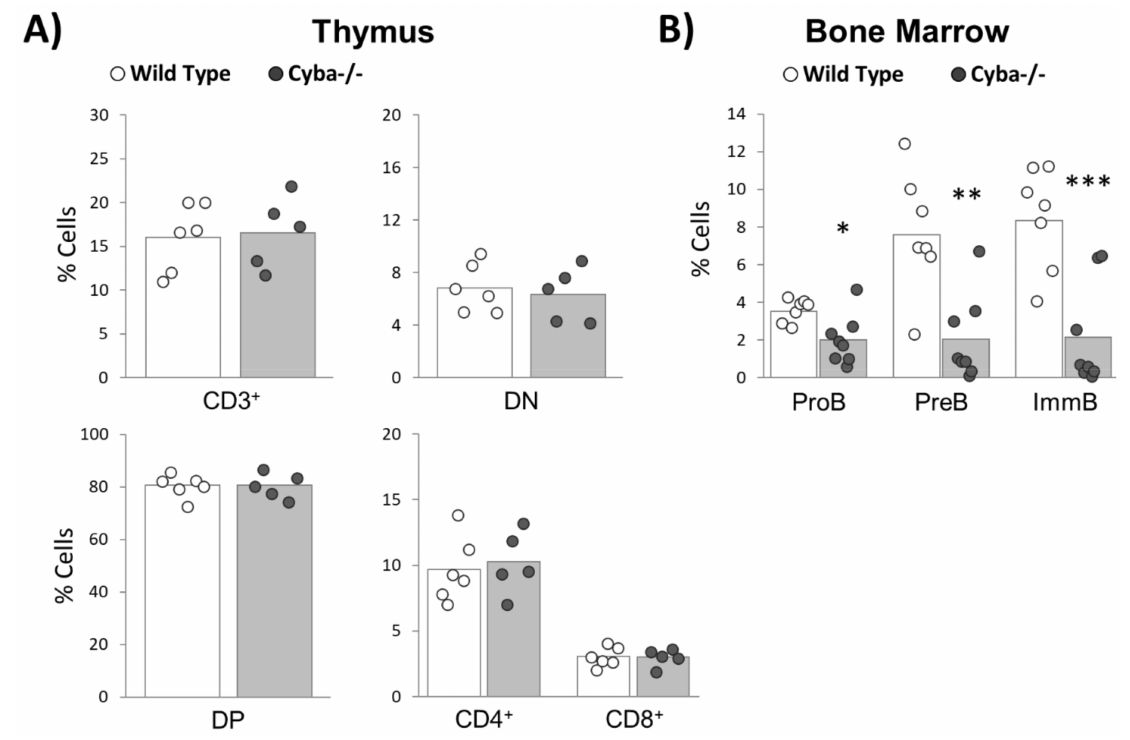
Figure 5. Granuloma-bearing Cyba − / − mice show an alteration in the differentiation of B-cells. ( A ) Analysis of T-lymphocyte differentiation stages in the thymus of Cyba − / − and control mice. DN: double-negative cells (CD4 ¯ CD8 ¯ ). DP: double- positive cells (CD4 + CD8 + ). ( B ) Analysis of B-lymphocyte differentiation stages in the bone marrow (BM) of Cyba − / − and control mice. ProB: B220 + CD43 + IgM − . PreB: B220 + CD43 − IgM − . ImmB: (immature B-cell) B220 + CD43 − IgM + . * p < 0.05, ** p < 0.01, *** p <